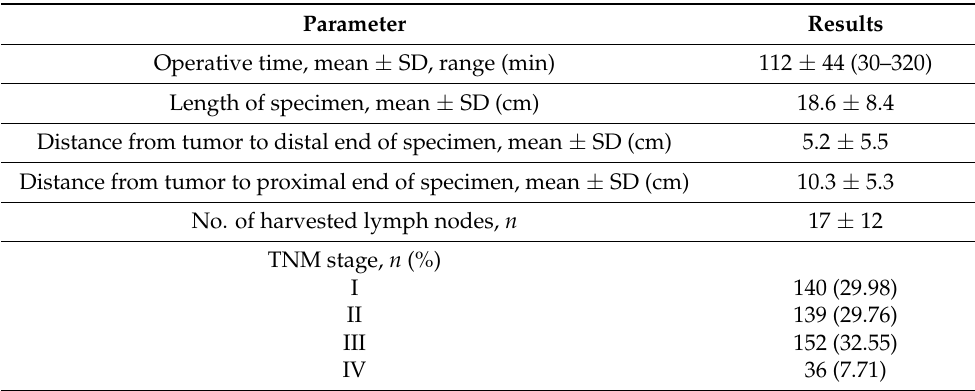
Table 2. Intraoperative outcomes and cancer stage by TNM staging system.